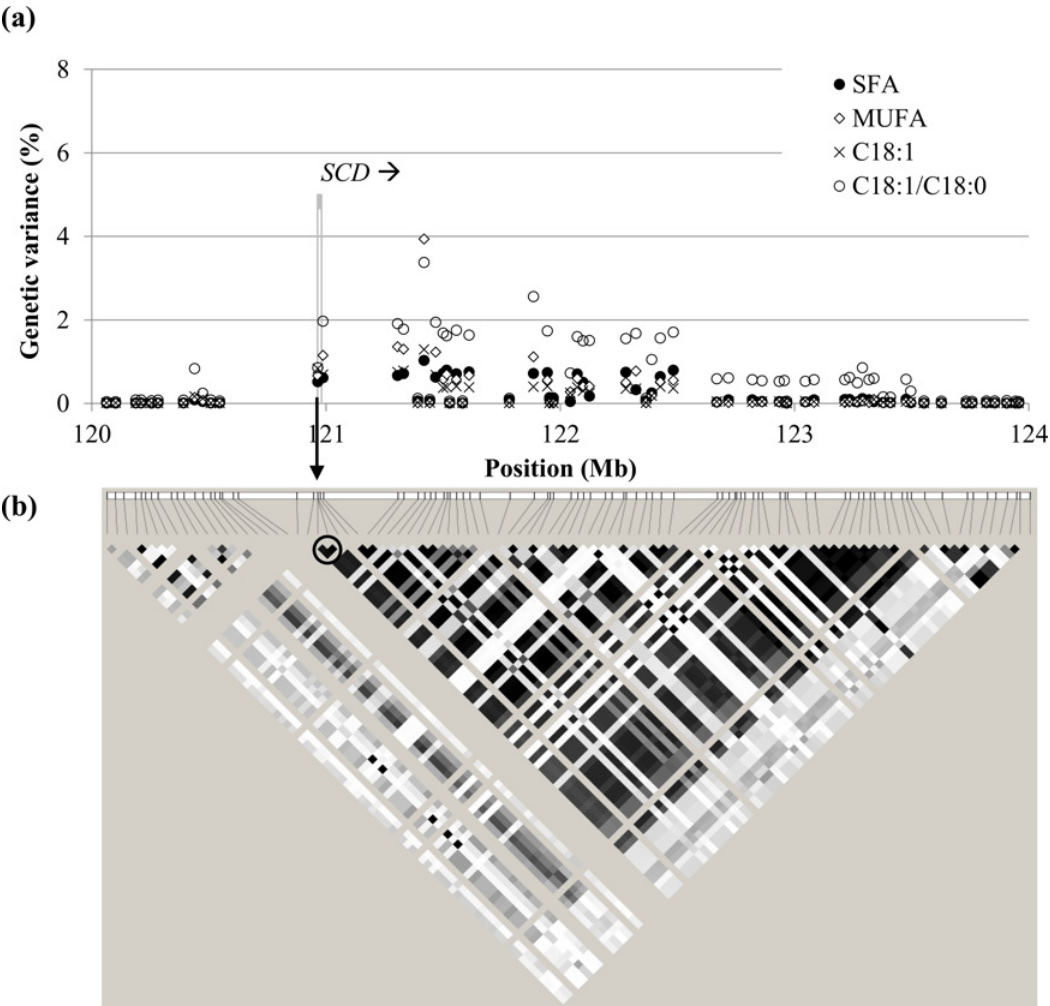
g . 2228T > C from the haplotype described in [12], indicated with an arrow, is not provided in the chip. The grey stripe indicates the location of candidate gene SCD and the arrow indicates sense of transcription. Panel (b) shows the linkage disequilibrium in the region (white: r 2 = 0; black: r 2 = 1). Circled, the haplotype described in [12], in high linkage disequilibrium with several SNPs downstream associated to the